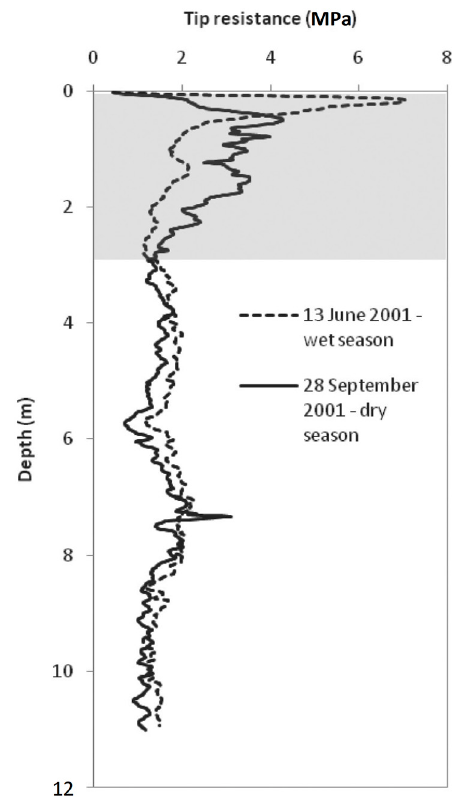
Figure 1. Measured tip resistance at Broni (PV, Italy). The highlighted layer shows the zone of influence of seasonal changes of the water table. Water table depths at 3.5 m and 5 m during dry and wet seasons respectively.